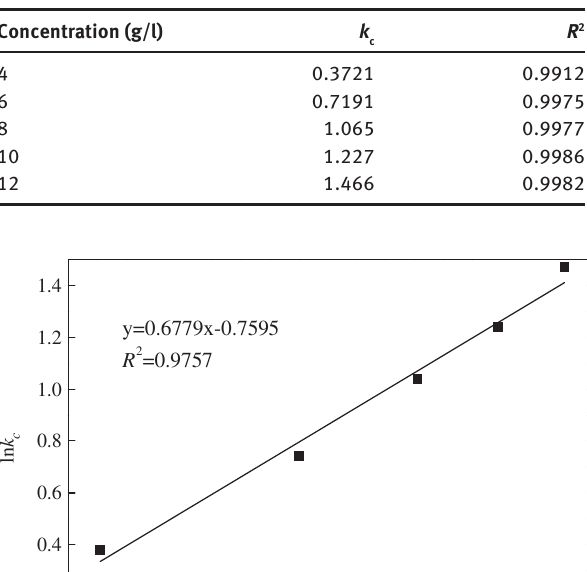
Table 3: Rate constants at different thiourea mass concentrations ) and correlation coefficients. ( k c